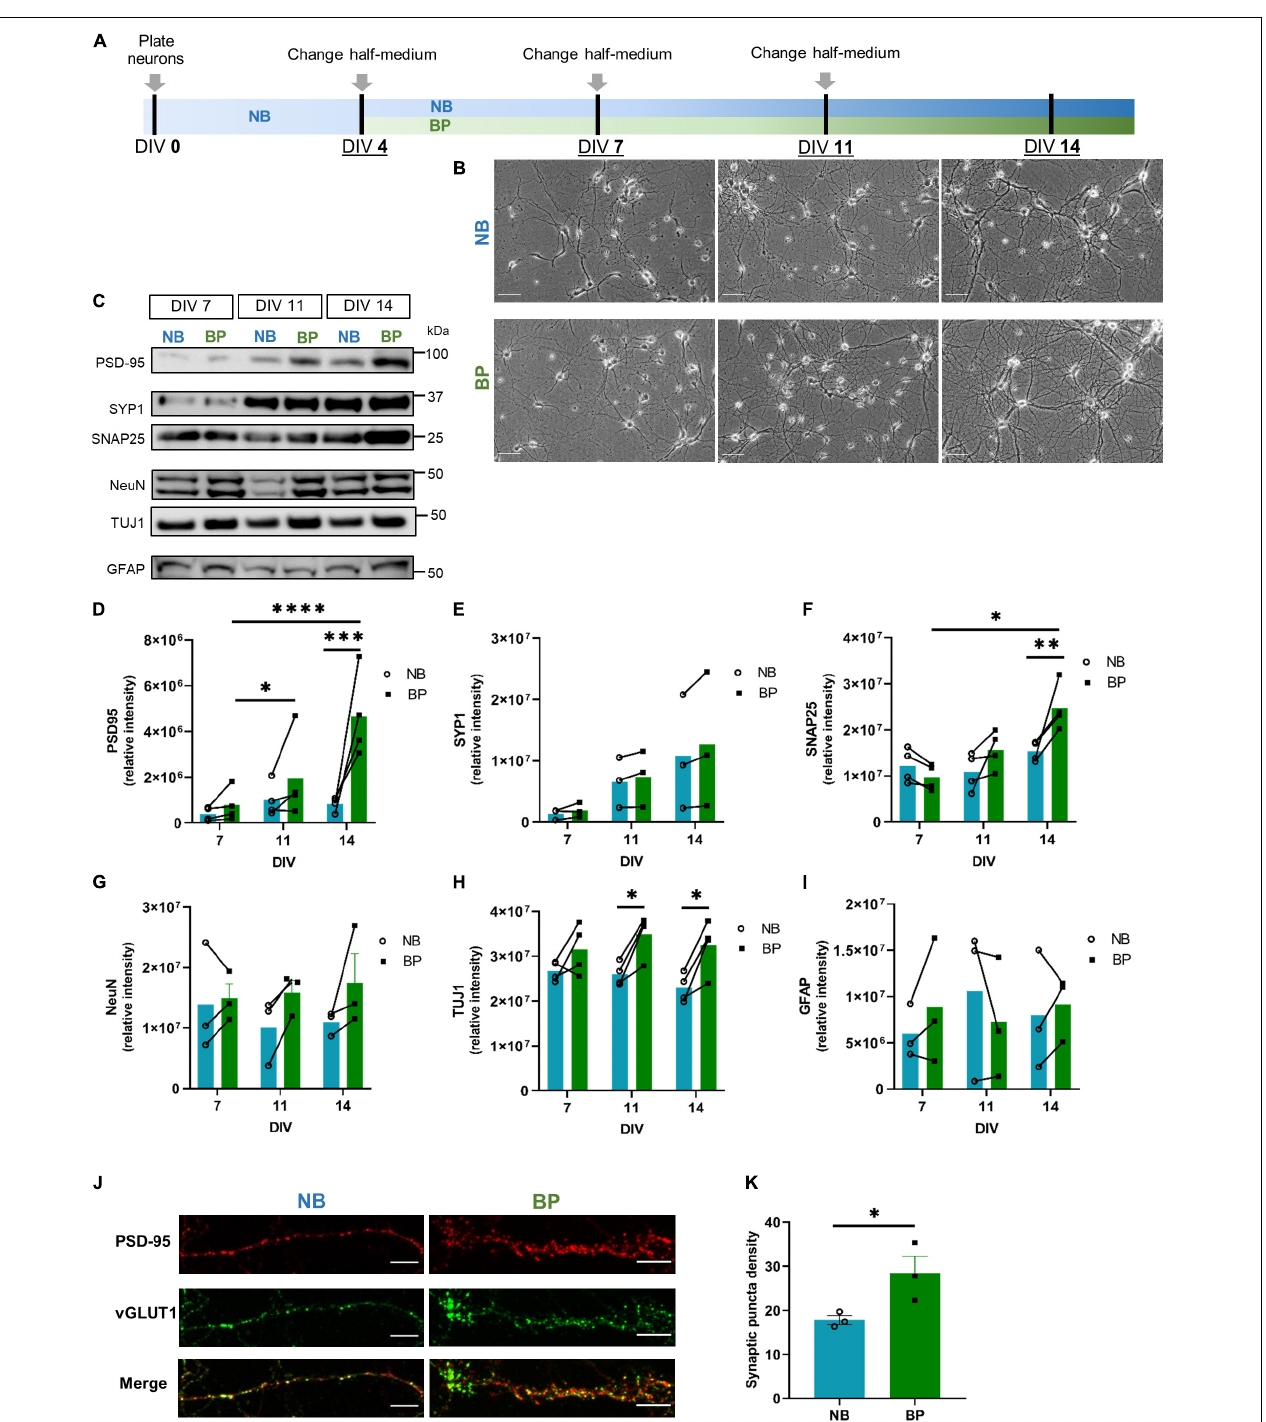
FIGURE 1 | Denser neuronal networks and increased expression of synaptic markers in mouse neurons maintained in BrainPhys (BP) medium. (A) Schematic representation of mouse primary neuronal culture timeline employed to compare Neurobasal (NB) and BP media; (B) wide-field images of primary mouse neurons maintained in either NB or BP media at DIV7, DIV11, and DIV14 (scale bar = 100 µ m); protein expression (C) and respective quantification of postsynaptic (PSD-95) (D) ; presynaptic–Synaptophysin1 (E) , SNAP25 (F) ; neuronal–NeuN (G) , TUJ1 (H) , and astrocytic–GFAP (I) markers in neurons maintained in NB or BP media and collected at DIV7, DIV11, and DIV14. (J) Expression of presynaptic (vGLUT1; green) and postsynaptic (PSD-95; red) markers in neurons maintained in NB and BP at DIV14. (K) Quantification of the area analyzed that is occupied by the synaptic puncta (scale bar = 10 µ m). All graphs show means ± SEM determined by two-way ANOVA followed by Bonferroni’s multiple comparisons post hoc test (D–I) and unpaired student’s t -test (K) ; ∗ p < 0.05, ** p < 0.01, *** p < 0.001, **** p < 0.0001 ( n = 3–4 biological replicates).